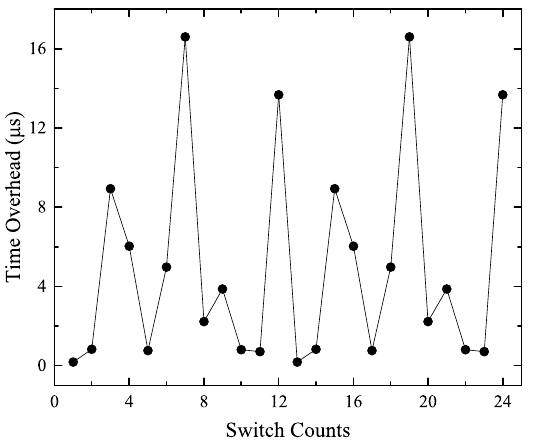
Figure 3. Context switch time overhead of Linpack_bench.